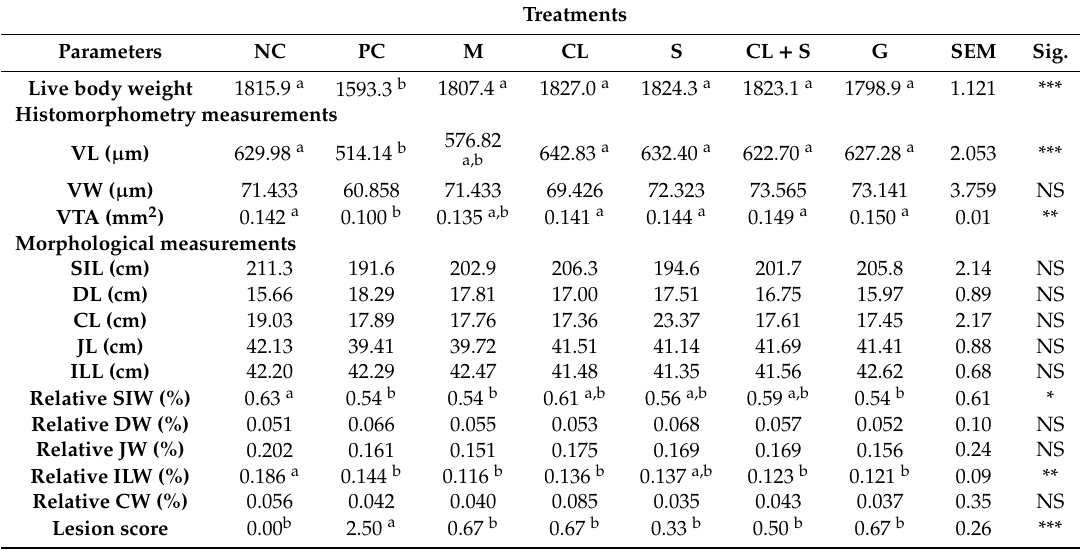
Table 4. E ff ect of probiotic diet supplementation on histomorphometric measurements in the intestine of broiler chicks challenged with C. perfringens